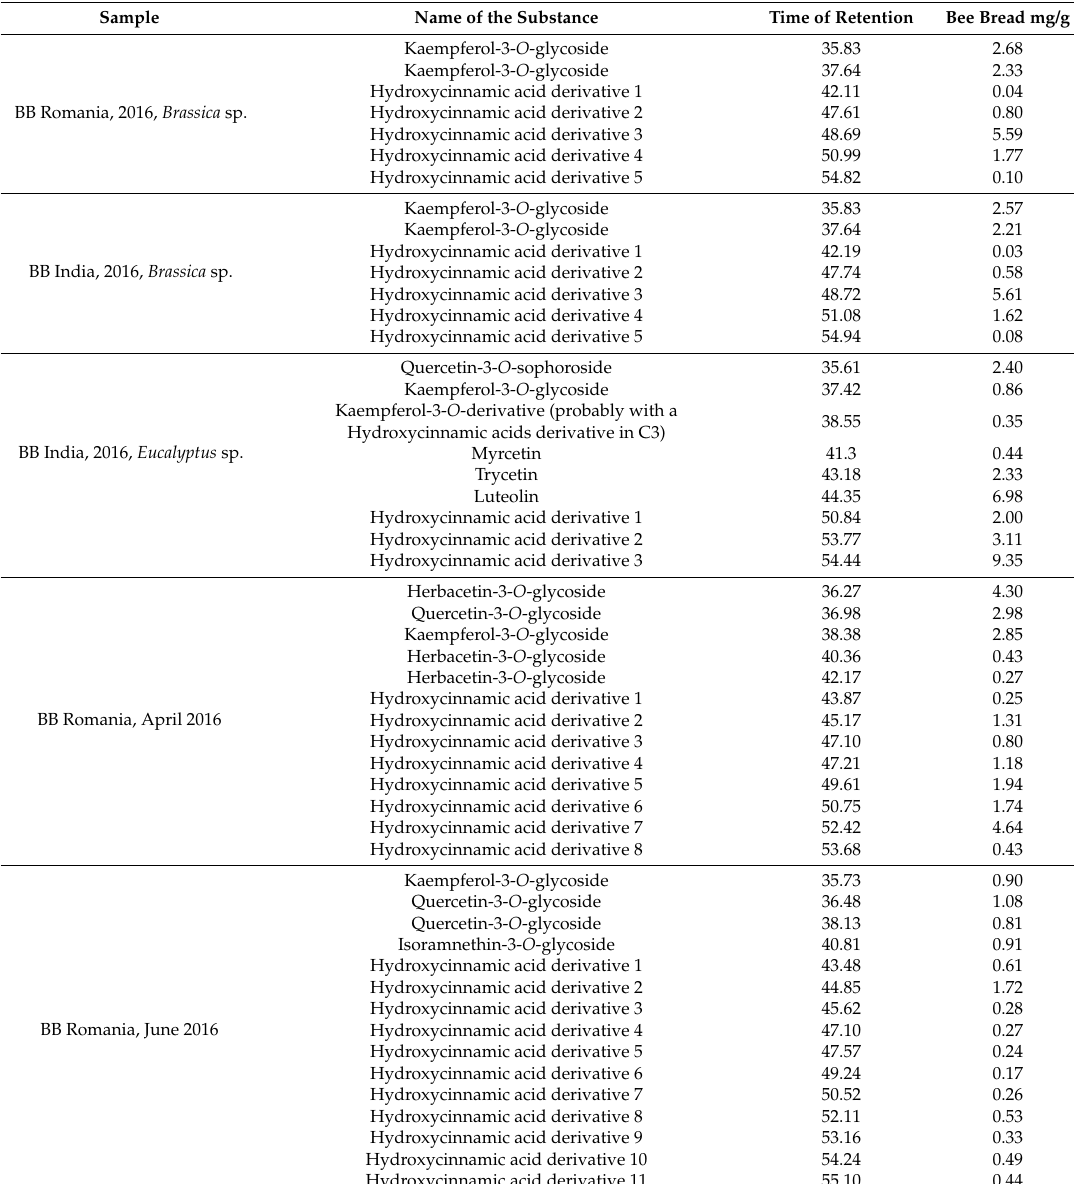
Table 4. Content of the flavonoids and Hydroxycinnamic acids derivatives identified in BB extracts by HPLC/DAD. The quantification was carried out at 260 nm. Sample